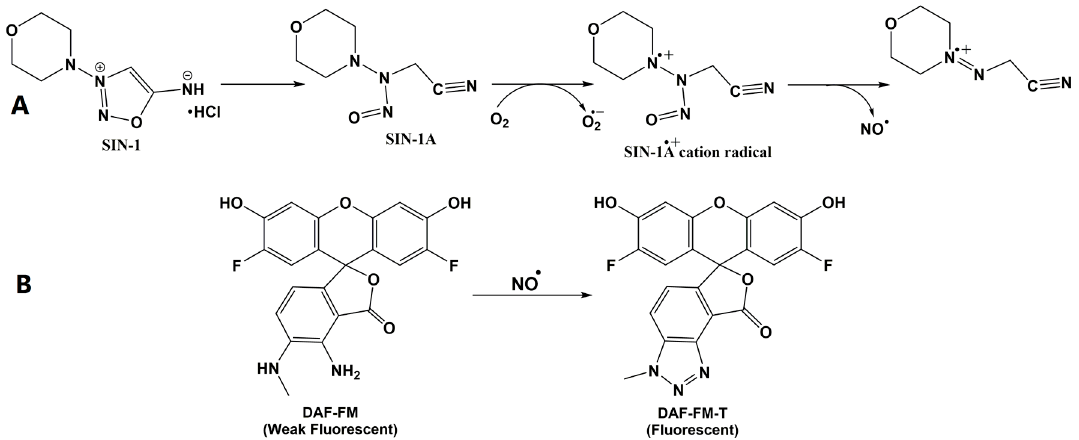
Figure 1. Schematic representation of ( A ) the suggested reaction liberating nitric oxide (NO) from 3-morpholinosydnonimine hydrochloride (SIN-1) and ( B ) the reaction of 4-amino-5-methylamino- 2 ′ ,7 ′ -difluorofluorescein (DAF-FM) with NO generated from SIN-1.